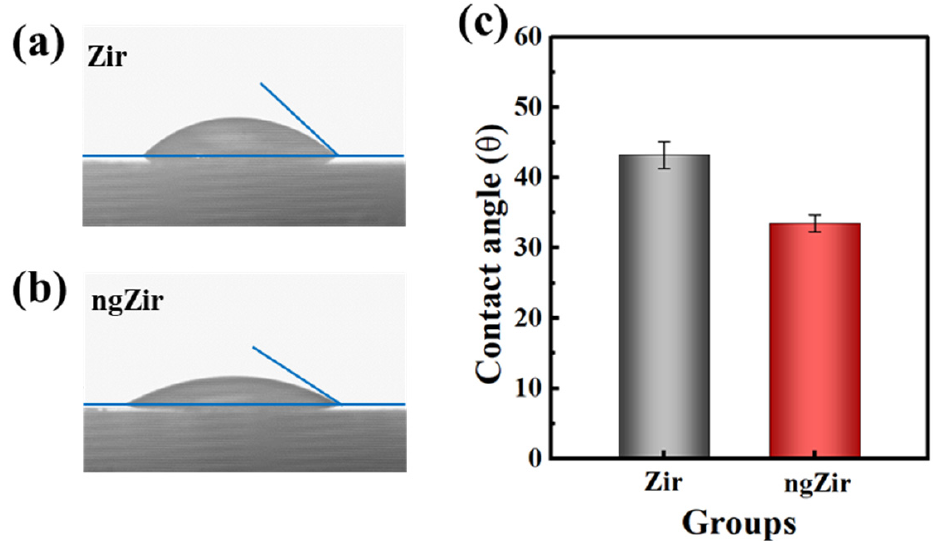
Figure 5. The contact angles of Zir ( a ) and ngZir ( b ), and the contrast of contact angles ( c ) before and after modification of after modification of zirconia.